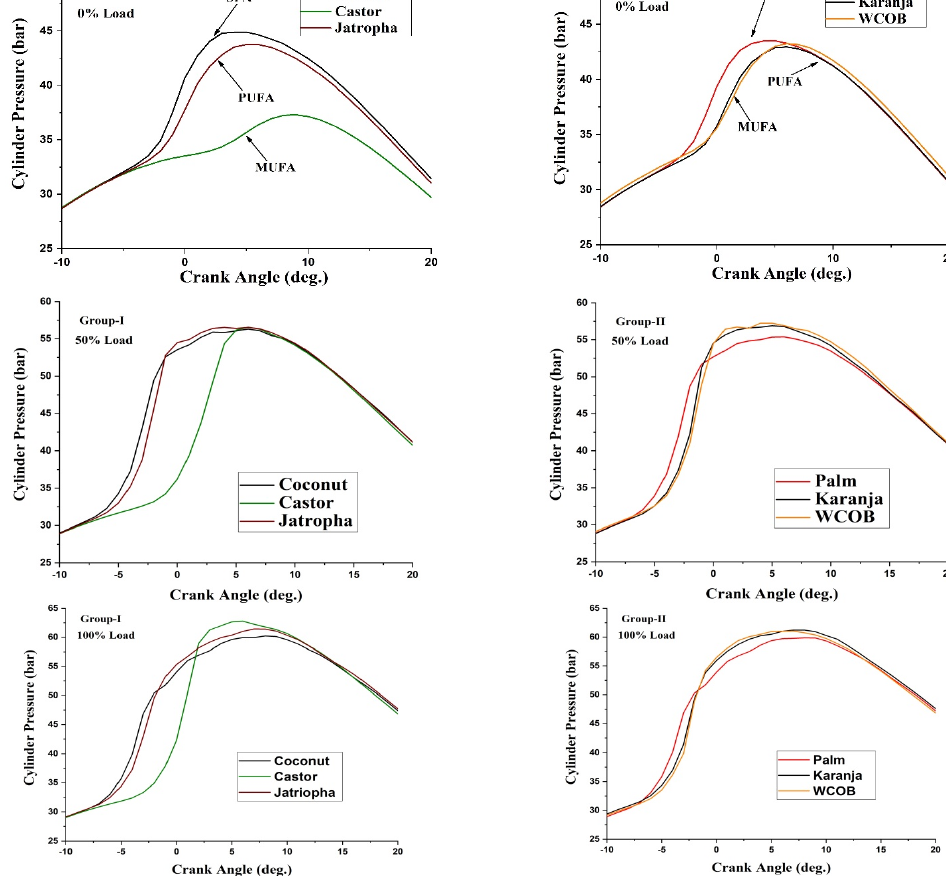
Figure 6. Variation of in-cylinder pressure as a function of engine load and biodiesel type.